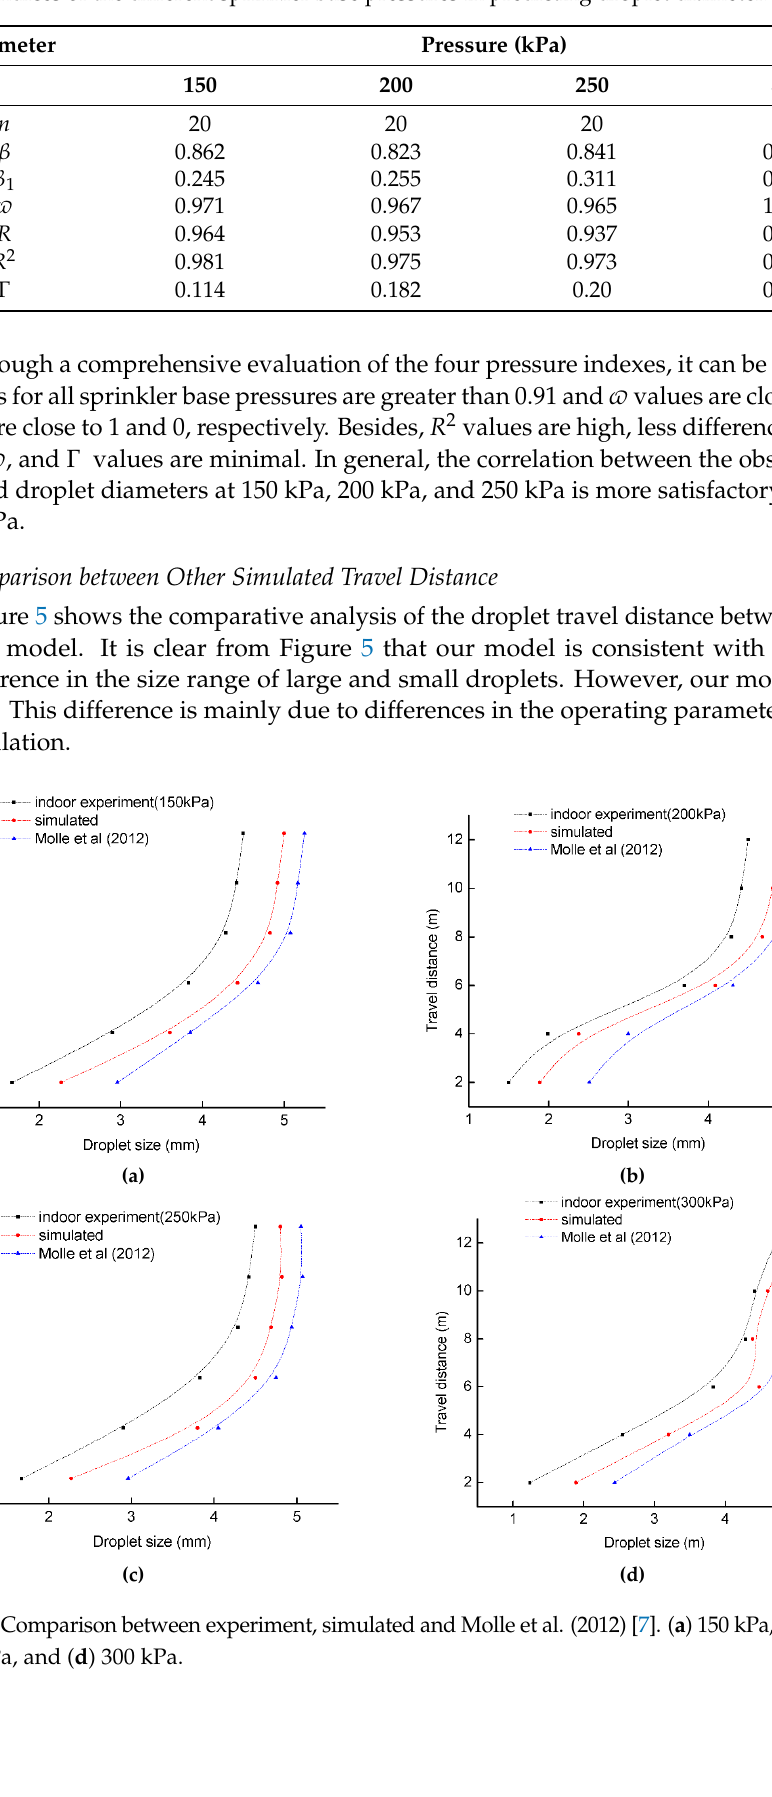
Table 3. Indices of the different sprinkler base pressures in predicting droplet diameter.